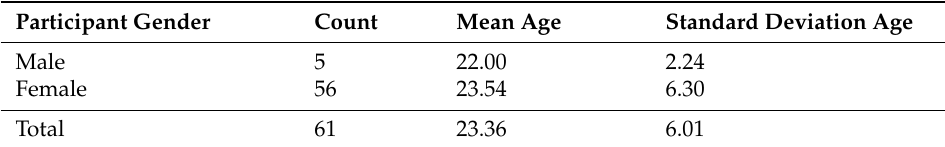
Table 2. Description of the evaluation sample.